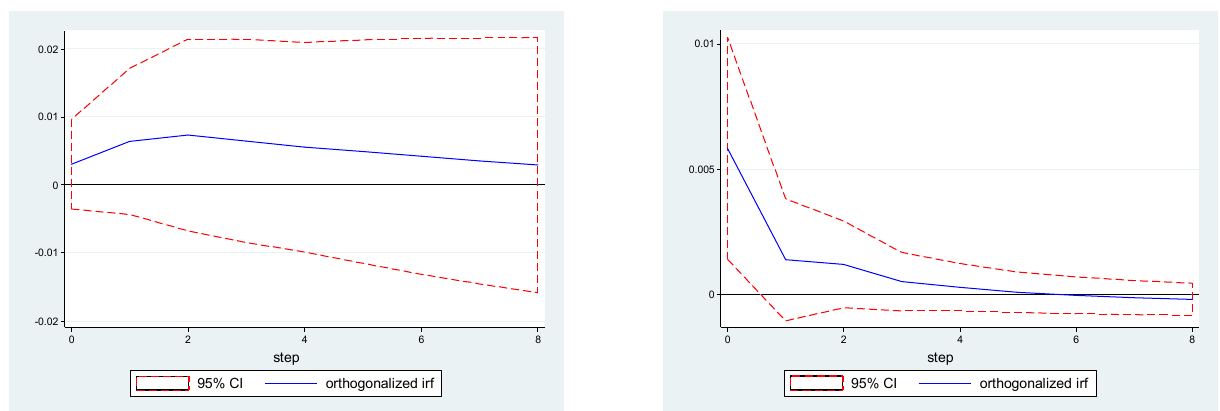
Figure 6. Impulse Response of lnCurrency to Expect and Shortcapital to lnCurrency.